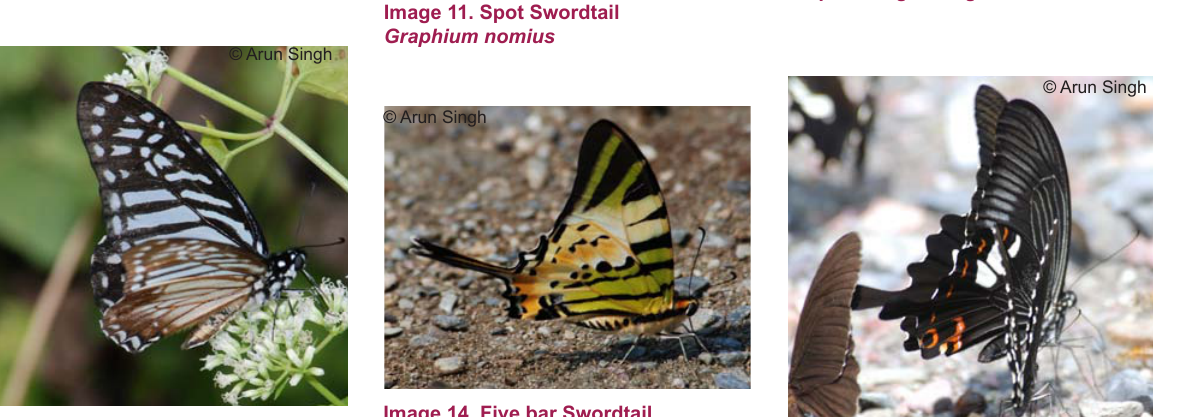
Images 9 & 10. Common Blue Bottle, Graphium sarpedon and Common Jay, Graphium doson